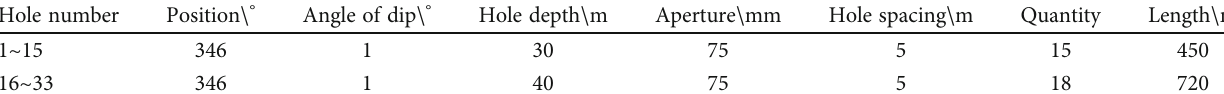
Table 4: 13817 coal mining face through the fault drilling parameters table of this coal seam extraction.